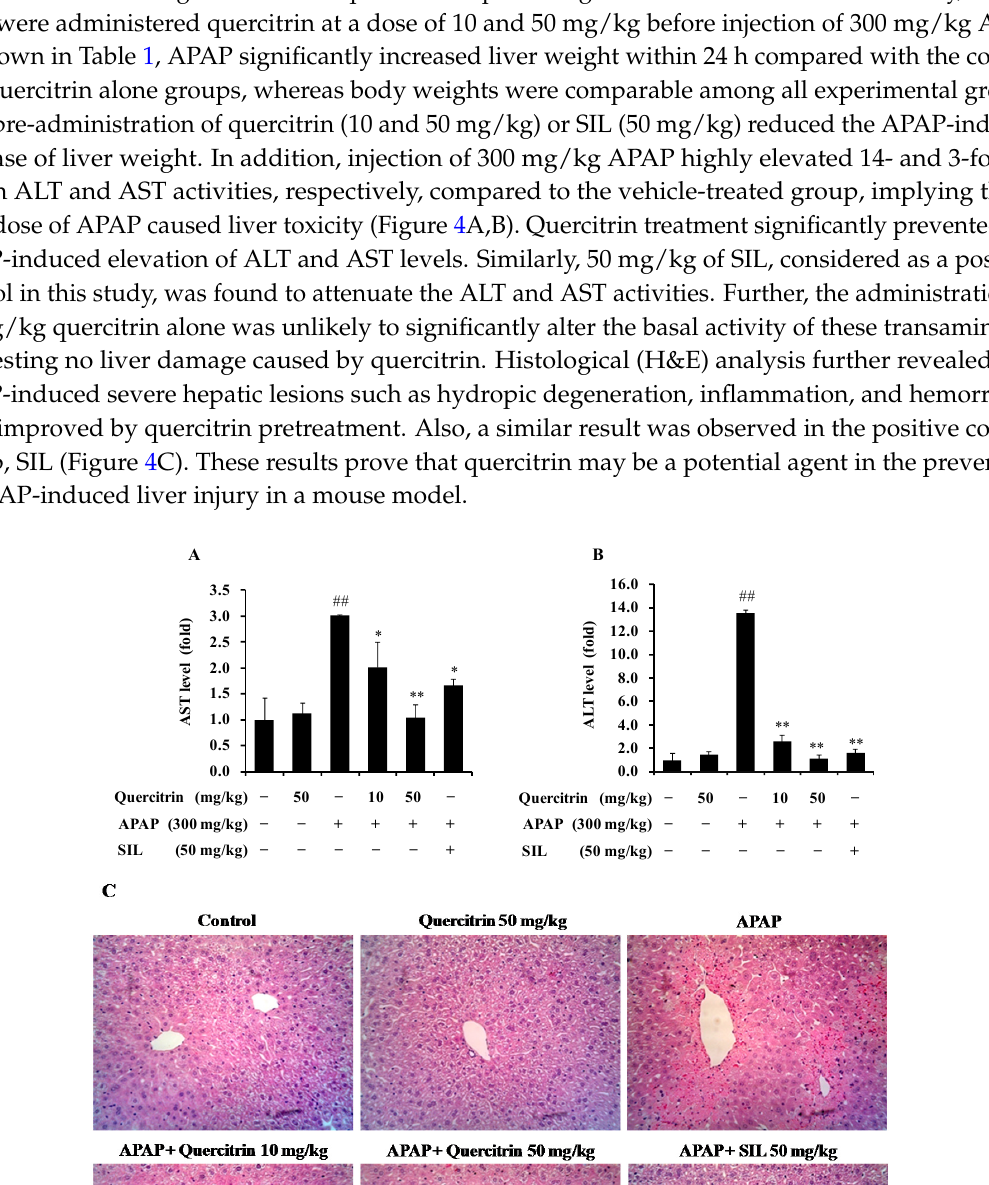
Table 1. Effect of quercitrin on body weight and liver weight/body weight (%) in APAP intoxicated mice.